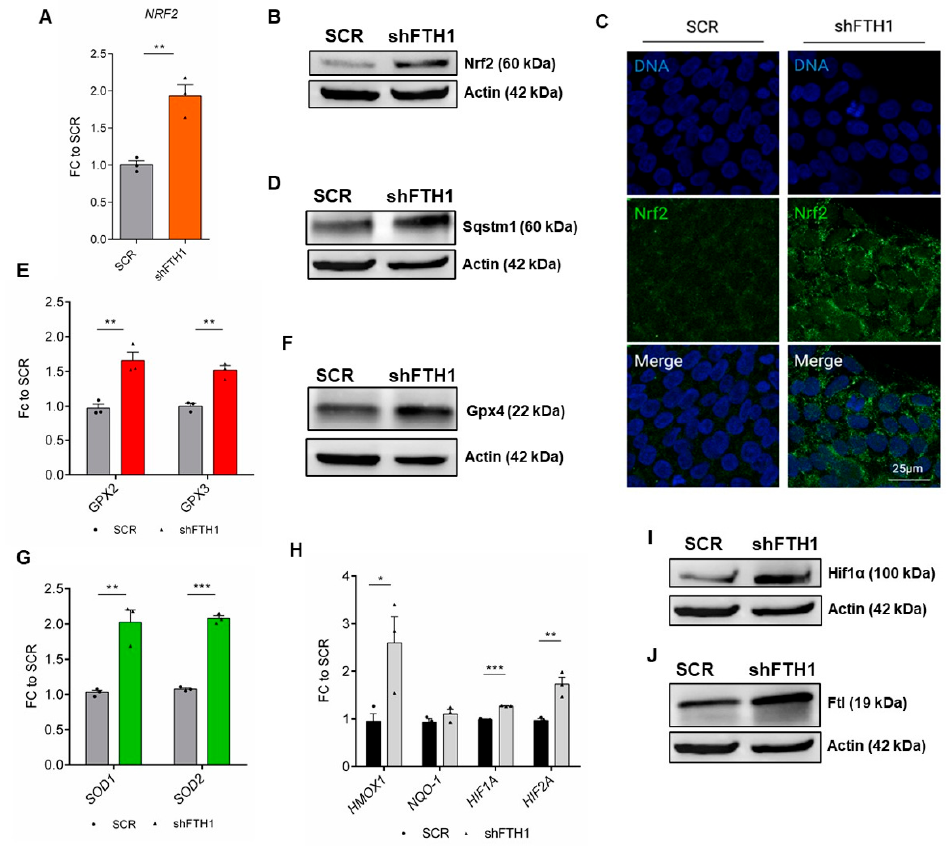
Figure 3. The Nrf2 pathway is activated in FTH1-KD hESCs. ( A ) NRF2 expression was measured in undifferentiated SCR and FTH1-KD hESCs via qRT-PCR, showing a significant up-regulation in presence of FTH1 silencing; ( B ) Nrf2 protein level was assessed by immunoblotting (IB), indicating an increased expression of FTH1-KD hESCs; ( C ) Immunofluorescence of Nrf2 (green) and nuclei (blue) in SCR control hESCs and FTH1 silenced cells (scale bar, 25 µm); ( D ) Immunoblot analysis for p62/Sqstm1 protein in SCR and FTH1-KD cells showing an upregulation of its expression in silenced cells; ( E ) qRT-PCR analysis of glutathione peroxidases 2 and 3 ( GPX2 , GPX3 ) antioxidant genes in SCR control and FTH1-KD hESCs; ( F ) Western blot analysis for Gpx4 protein, confirming increased expression of FTH1-KD hESCs; ( G ) qRT-PCR analysis of SOD1 and SOD2 expression in SCR and shFTH1 hESCs showing an upregulation of these genes in modulated hESCs; ( H ) mRNA levels of Nrf2 target genes ( HMOX1 , NQO-1 , HIF1 α , HIF2 α ) were measured in SCR and FTH1-KD hESCs via qRT-PCR; ( I, J ) Immunoblot analysis of HIF1 α ( I ) and ferritin light chain (Ftl) ( J ) showed upregulation of both proteins in FTH1-silenced cells with respect to SCR cells. In all Western blots presented in this figure, actin levels were evaluated to confirm equal loading control. qRT-PCR data were normalized to values in SCR cells and are represented as mean ± SEM ( n = 3); significance is calculated by t- test : * p ≤ 0.05; ** p ≤ 0.01, *** p ≤ 0.001 . Small dots refer to SCR replicates, while triangles refer to shFTH1 triplicates. 3.4. Effects of FTH1 Knock-Down on Apoptosis Labile iron accumulation is a well-known cell damage effector and pro-apoptotic factor [44–46]; intracellular iron overload by ferric ammonium citrate (FAC) treatment leads to ferroptosis, an iron-regulated cell death [47]. To check the effects of FTH1- silencing on apoptosis, expression analysis of intrinsic pro-apoptotic genes such as BAX and BIM , as well as CASP9 and CASP3 was performed, revealing a significant upregulation in FTH1-KD hESCs compared to SCR control (Figure 4A,B). Similarly, immunoblot analysis of cleaved Caspase3 protein confirmed its overexpression in FTH1- silenced hESCs (Figure 4C, Supplementary Figure S5A,E). Further, flow cytometry-based analysis of apoptosis showed a significantly higher percentage of late apoptotic cells in